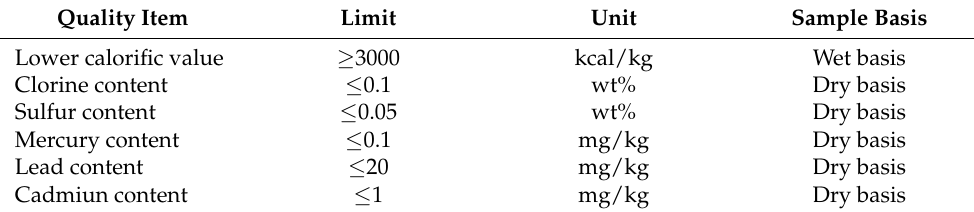
Table 3. Quality standards of primary solid biomass fuel in Taiwan.